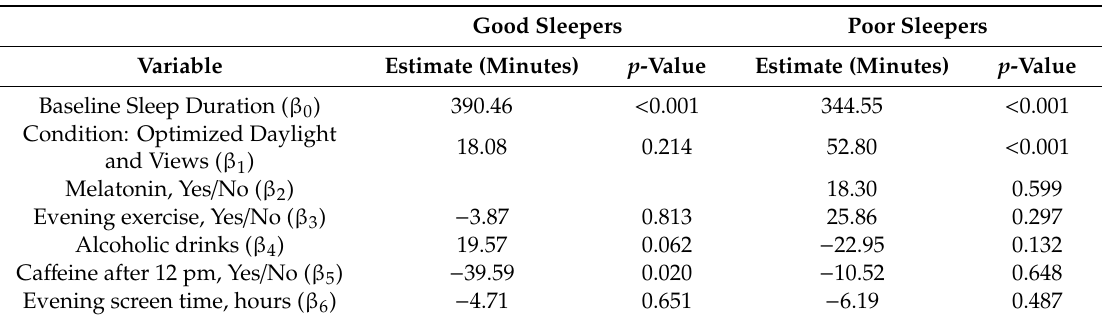
Table 4. Linear mixed e ff ects model of sleep duration by o ffi ce condition and lifestyle factors (use of melatonin, engagement in exercise, number of alcoholic drinks, ca ff eine intake after noon, and evening screen time duration), stratified by baseline sleep